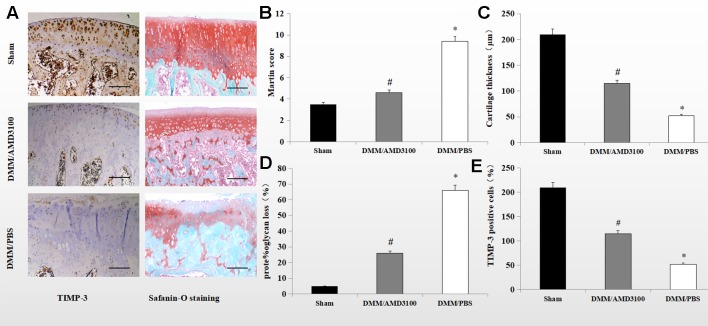
AMD3100 protects OA cartilage from proteoglycan loss and maintains TIMP-3 levels. (A) Safranin orange staining and immunostaining of TIMP-3 in knee sections from the sham, PBS-treated, and AMD3100-treated groups (scale bar, 100 µm). (B) Mankin scores of articular cartilage from the sham, AMD3100-treated and PBS-treated groups (n = 9 per group); (C) Cartilage thickness (n = 9 per group); (D) Proteoglycan loss from knee cartilage (n = 9 per group). (E) Number of TIMP-3 positive chondrocytes in knee cartilage (n = 9 per group). *DMM/PBS compared to sham group (p < 0.05); #DMM/3100 compared to DMM/PBS group (p < 0.05).